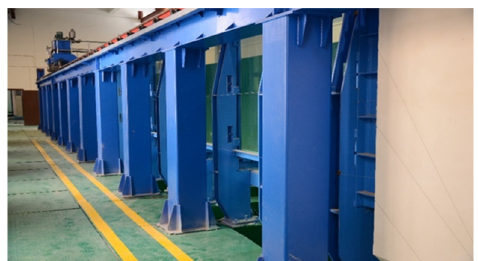
Figure 6. Experimental pool.